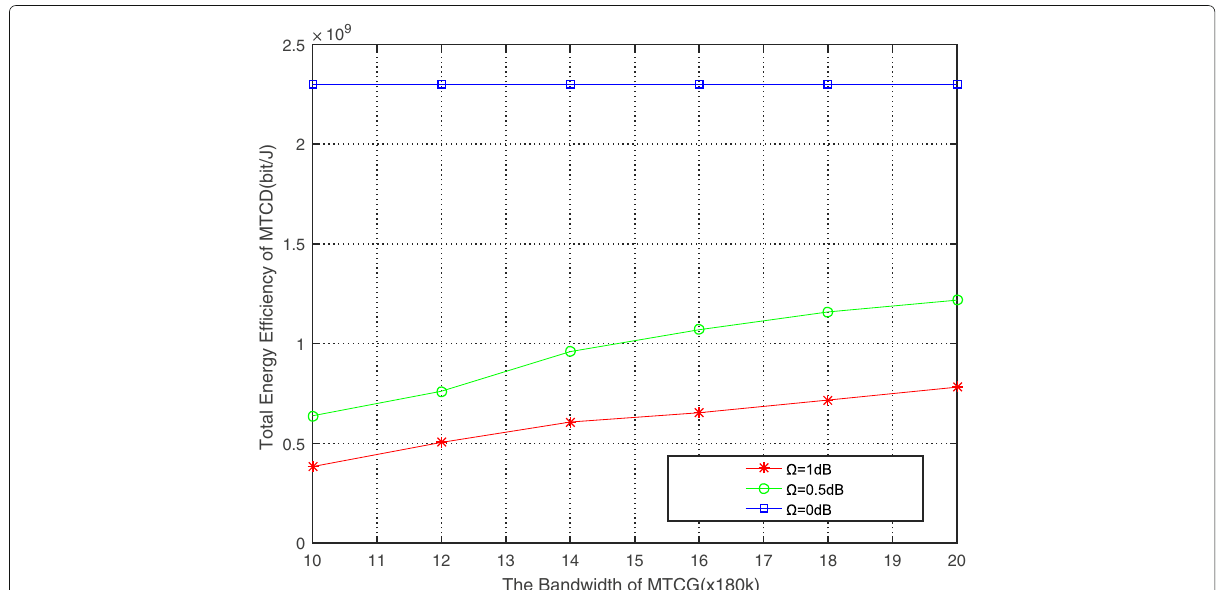
Fig. 5 The total energy efficiency with different MTCG’s bandwidths. The MTCDs are uniformly distributed in 100-m radius of the MTCG, and the MTCG is uniformly distributed in 1000-m radius of the BS. The payload of each MTCD is 300 bit/TTI, and the number of groups of MTCDs is K = 10